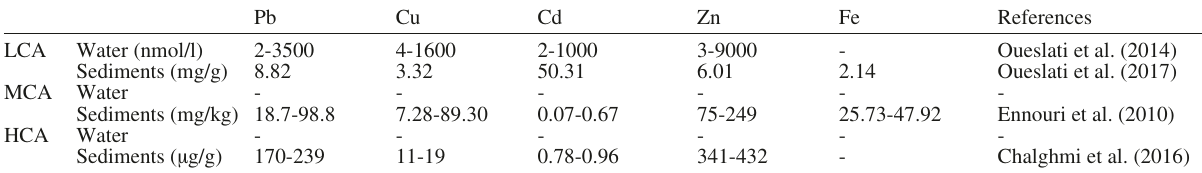
Table S3. – Levels of trace elements in the water column and sediments of Tunisian lagoons: Ghar el Melh (LCA), the North Lake (MCA) and the South Lake (HCA). Pb Cu Cd Zn